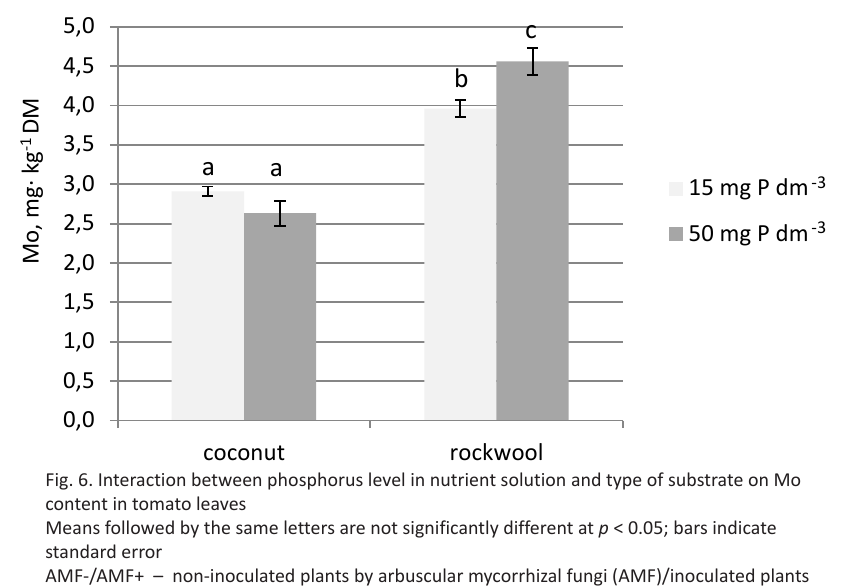
Fig. 6. Interaction between phosphorus level in nutrient solution and type of substrate on Mo content in tomato leaves Means followed by the same letters are not significantly different at p < 0.05; bars indicate standard error AMF-/AMF+ – non-inoculated plants by arbuscular mycorrhizal fungi (AMF)/inoculated plants by